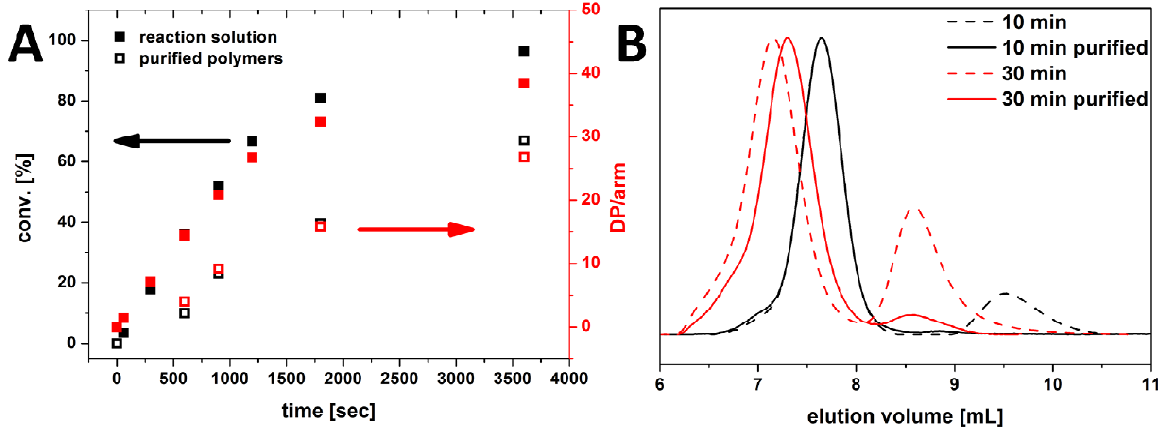
Figure 4. Time-dependent EtOx conversion (black squares) and the corresponding degrees of polymerization per arm (red squares) determined from the reaction mixture (filled squares) and after purification of the star-shaped block copolymers (empty squares) via NMR ( A ); SEC traces before (dashed line) and after purification via fractionated was used as the precipitation ( B ) (solid lines; CHCl 3